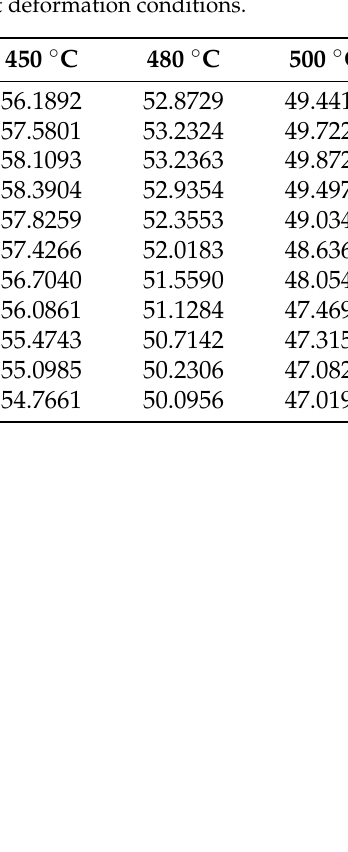
Figure 13. The value of the parameter K under different deformation condition.